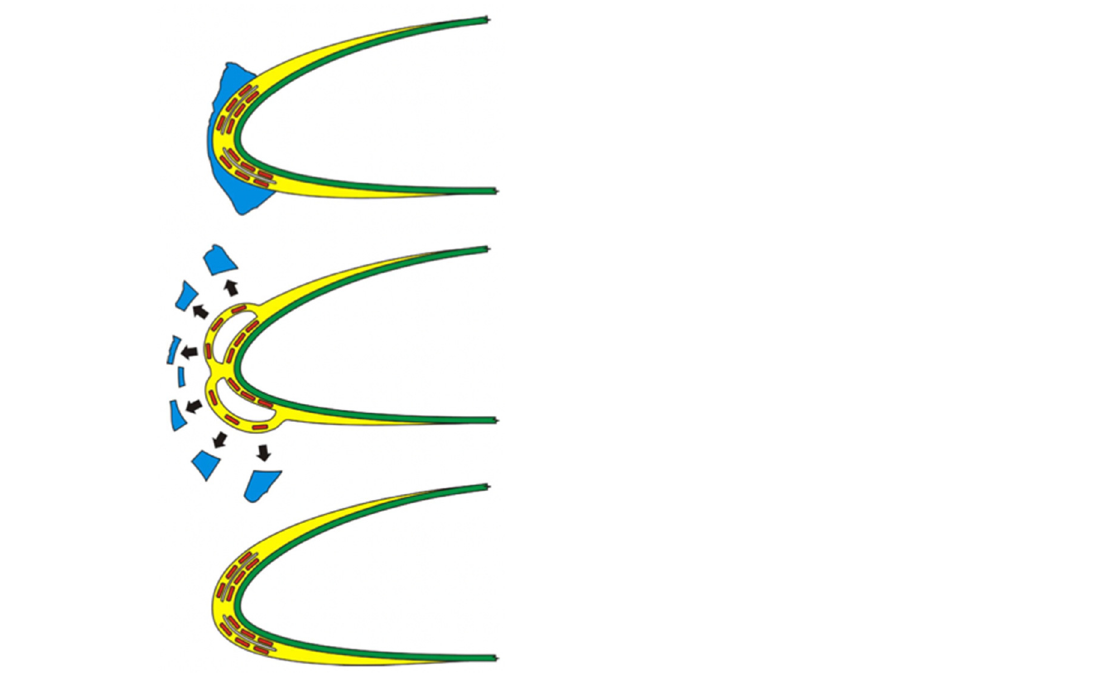
Figure 10. Deicing mechanism of EESS (Reproduced with permission from Goraj, Z. [125]).